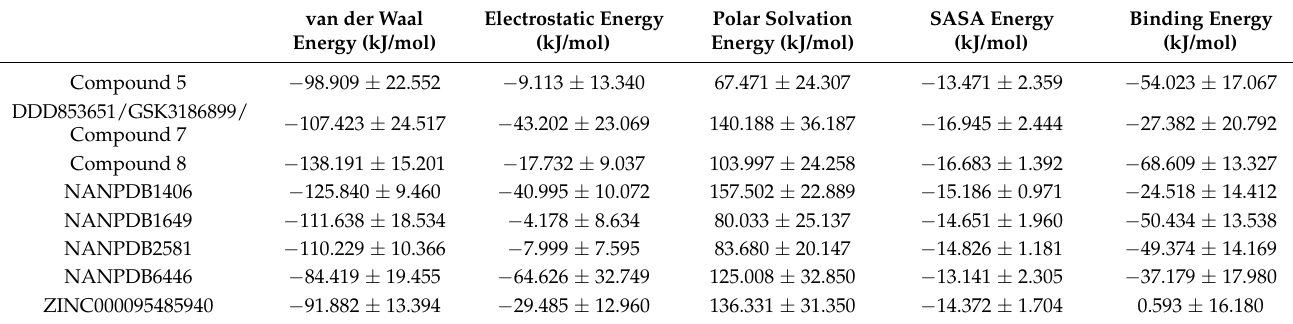
Table 11. Contributing energy terms of the MM/PBSA computations for the Ld CRK12–ligand complexes. Energy values are shown as average ± standard deviations in kJ/mol. SASA denote solvent accessible surface area. van der Waal Energy (kJ/mol)